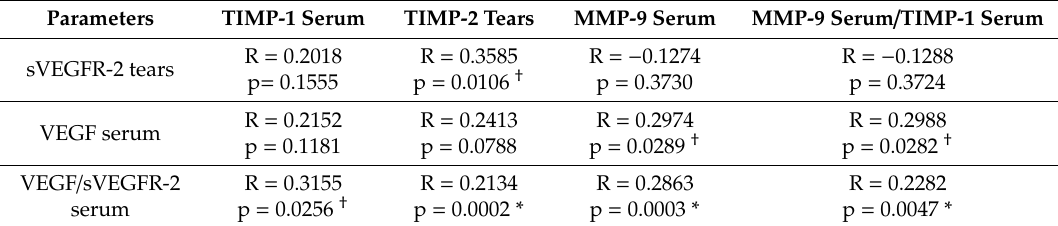
Table 3. Correlations between analyzed parameters in tears and blood serum samples from SSc patients and controls.